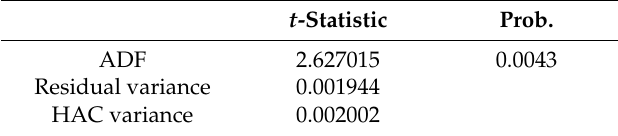
Table 8. Kao test of cointegration relationship in pollution industry. t